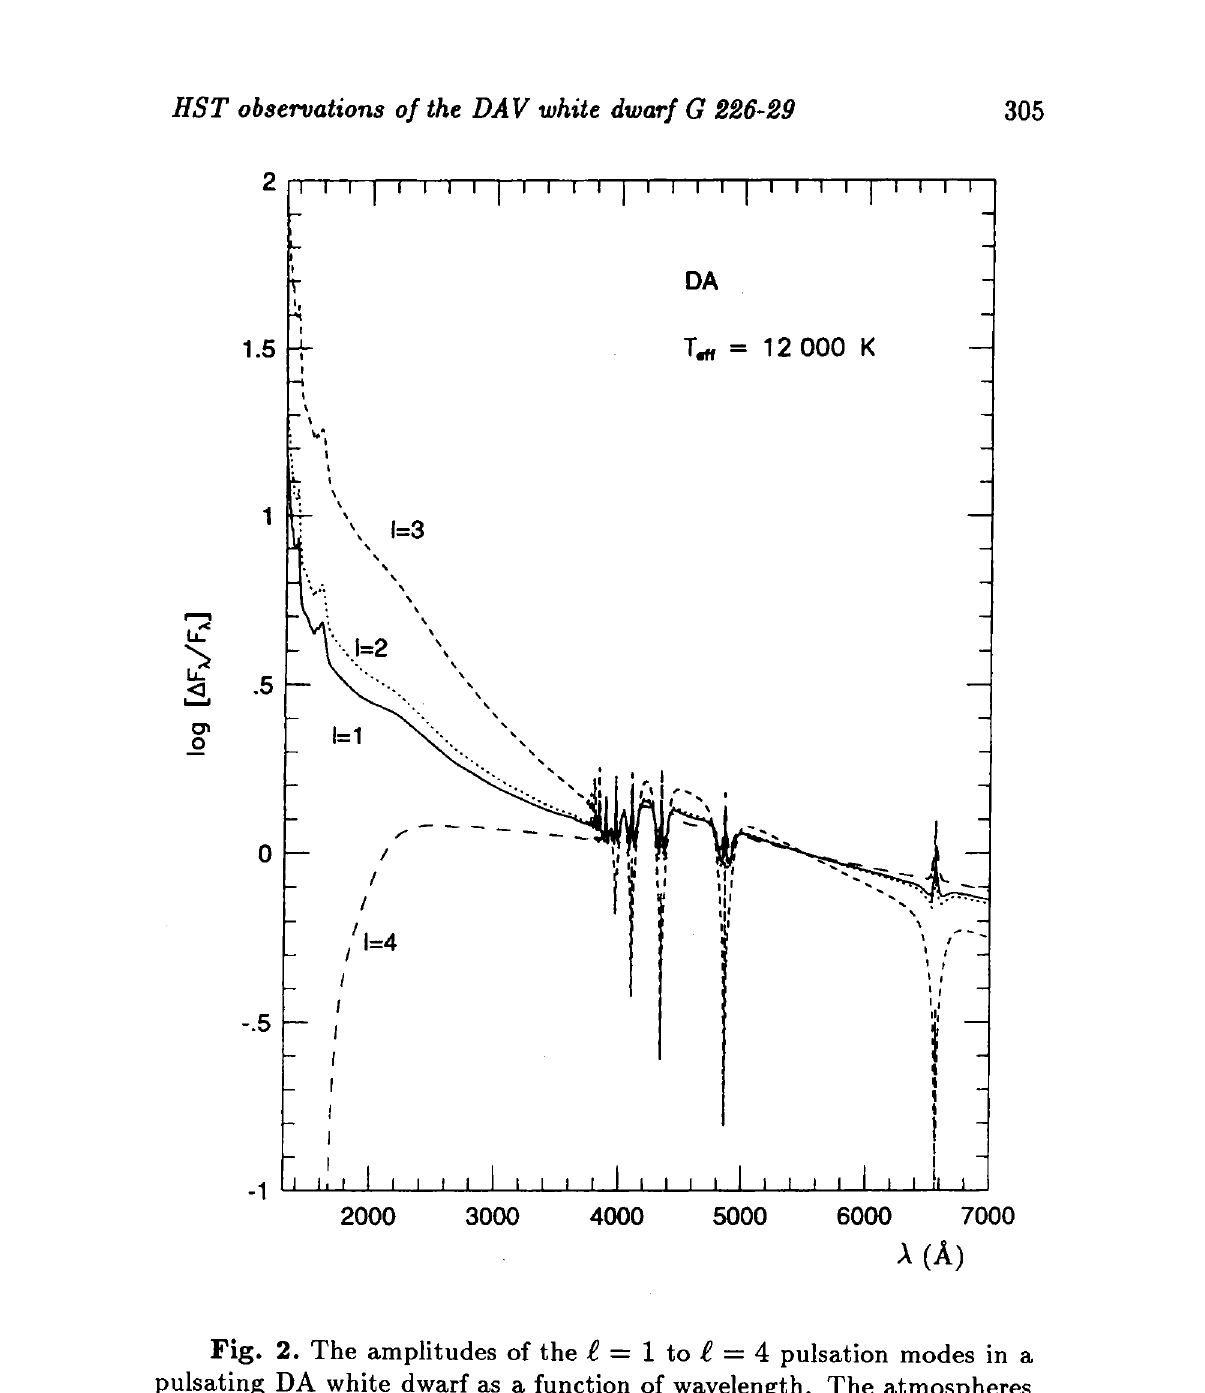
Fig. 2. The amplitudes of the I = 1 to I — 4 pulsation modes in a pulsating DA white dwarf as a function of wavelength. The atmospheres were calculated from the most recent version of the model atmosphere code by Koester et al. (1979). The amplitudes have been normalized to 1.0 at 5500